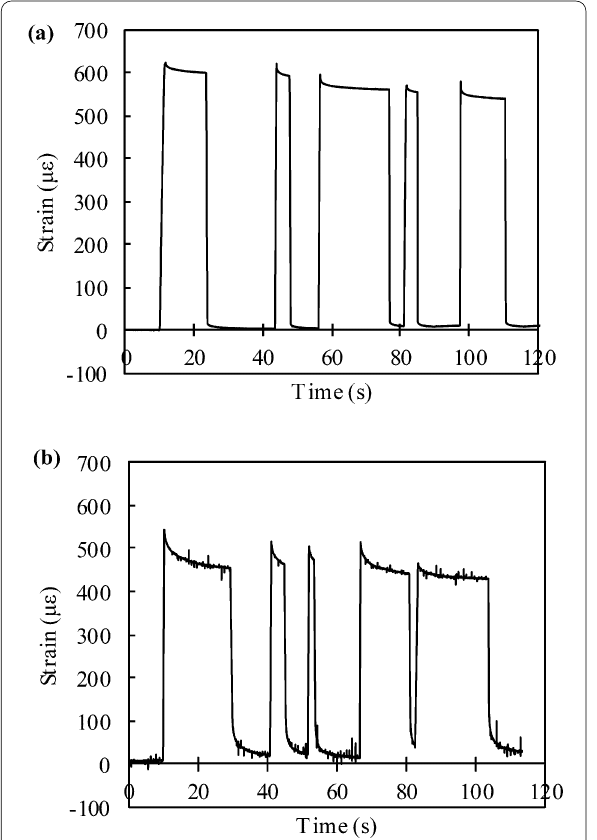
Fig. 11 Change in measured strain (sample 1). a T < T g . b T > T g . We resampled the obtained 1-kHz signal at 100 Hz using the resample() function of MATLAB